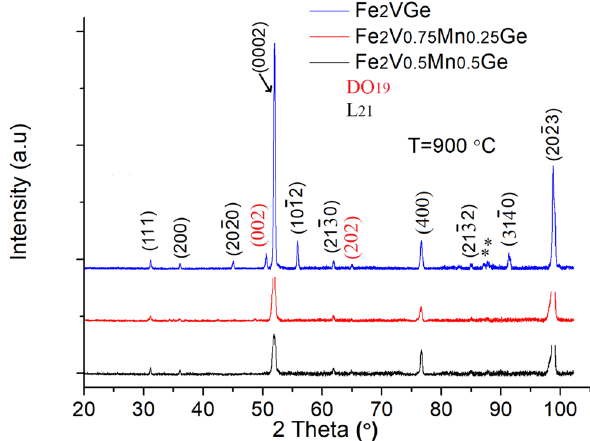
Fig. 1 The XRD patterns of Fe the indexes shown in red color belong to the possible DO agonal phase and the indexes in black color belong to L2 phase [10,